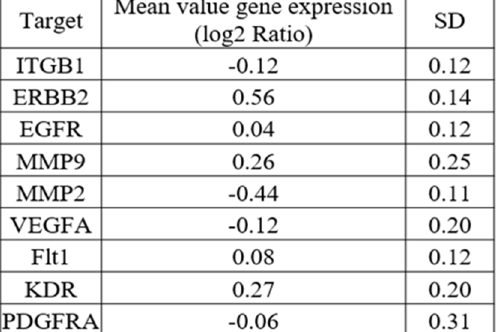
Figure 4. Data mining of target genes expression in human normal colon epithelial biopsies. Analysis of mean values of gene expression (log2 ratio) of selected target genes in ( A ) normal uninflamed sigmoid colon ( n = 24), ( B ) normal uninflamed terminal ileum ( n = 6), ( C ) normal uninflamed descending colon ( n = 22), ( D ) normal uninflamed ascending colon ( n = 17), and ( E ) all colon samples ( n = 69). Data were extracted at the GEO platform (GEO access number GDS3268 from [27]).